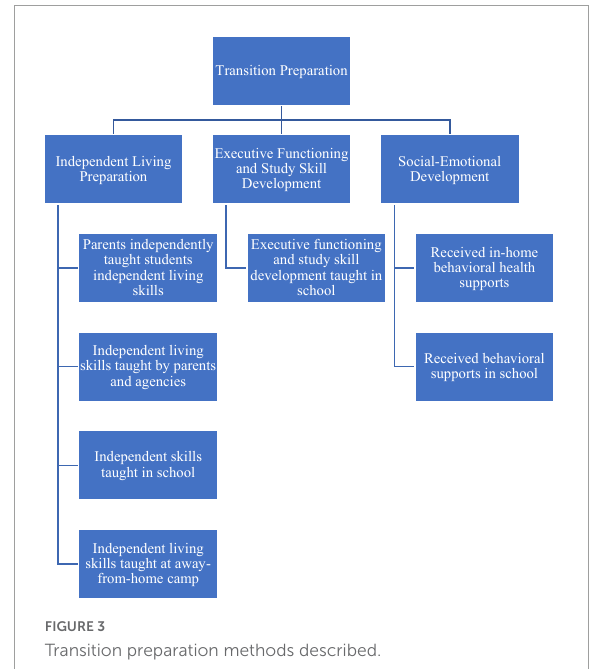
FIGURE3 Transition preparation methods